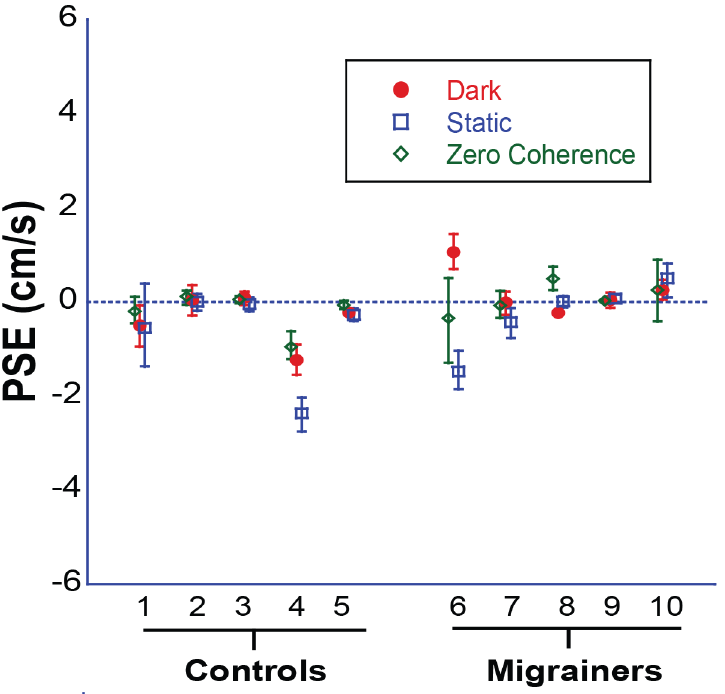
Fig 4. Individual Data for Experiment 1. Control Trials . Platform motion in darkness (red circles). Viewing a static visual stimulus (blue squares). Viewing a 0% coherence visual stimulus (green diamonds). Error bars represent 95%